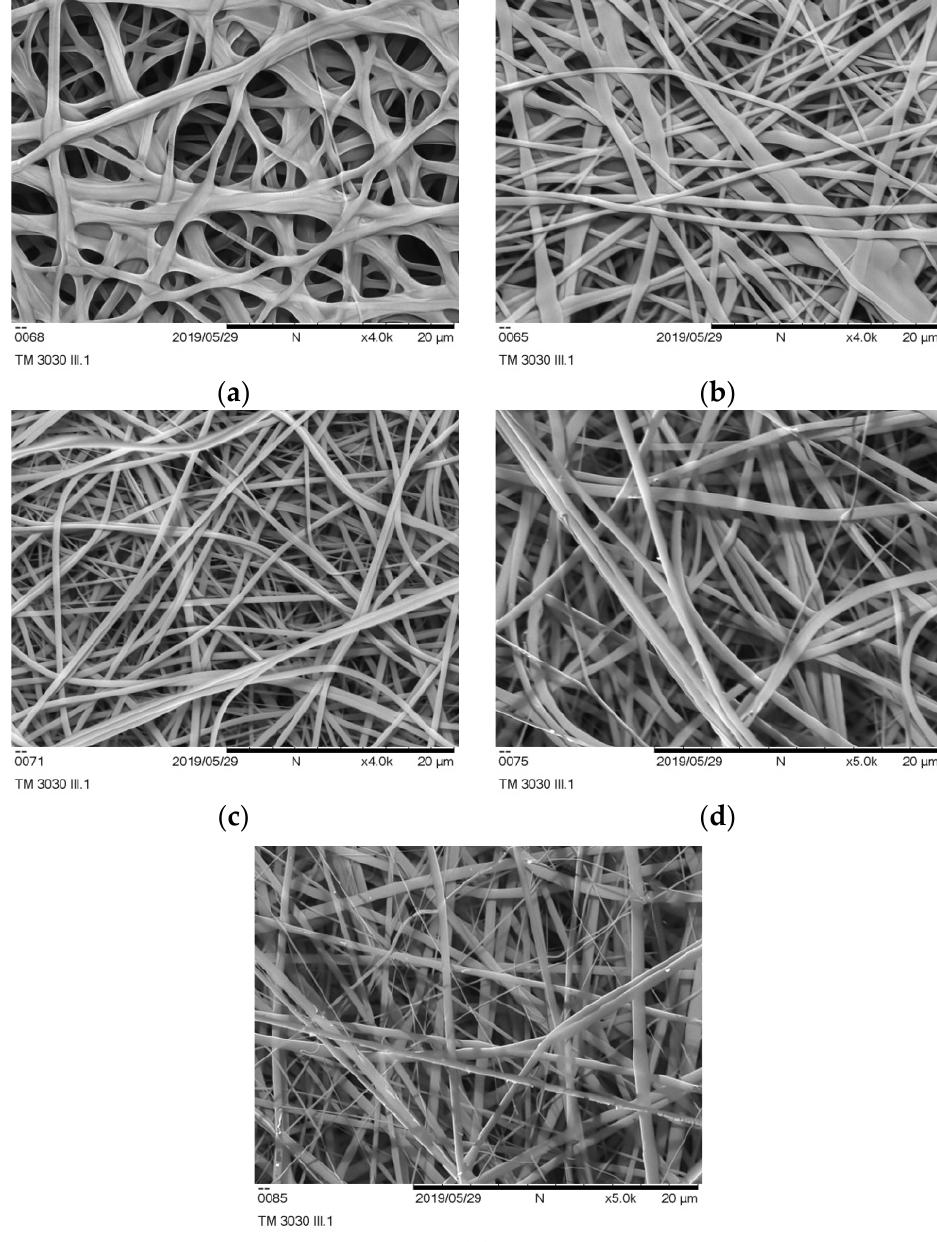
wt% sea-buckthorn oil, ( c ) PVP + 10 wt% sea-buckthorn, ( d ) PVP + 5 wt% pomegranate seed oil and ( e ) PVP + 10 wt% of mixture of pomegranate seed oil and extract of fermented pomegranate juice